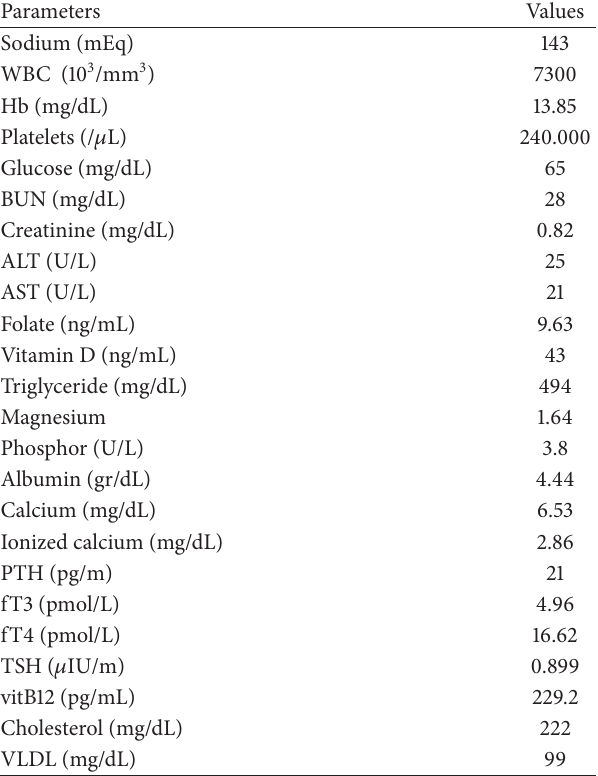
Table 1: Laboratory findings of the